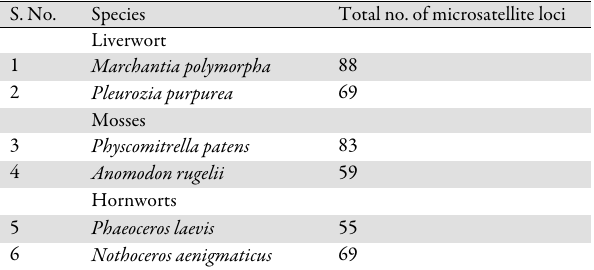
Table 2. Total number of microsatellite loci identified by screening mitochondrial genome sequence of bryophytes (Zhao et al ., 2014) S. No.